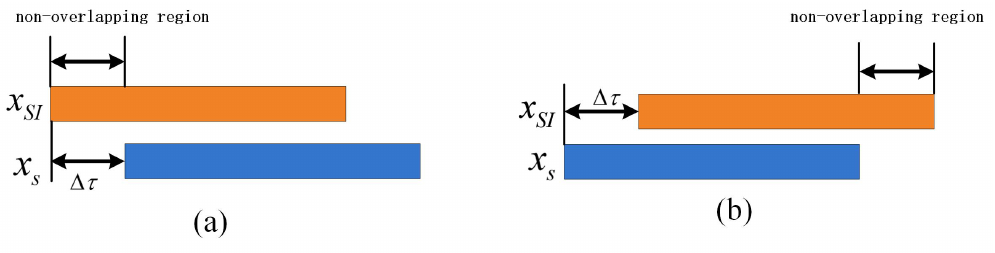
Figure 2. Signal model of asynchronous IBFD-UWA communication system: ( a ) SI is located before intended signal ( b ) SI is located behind intended